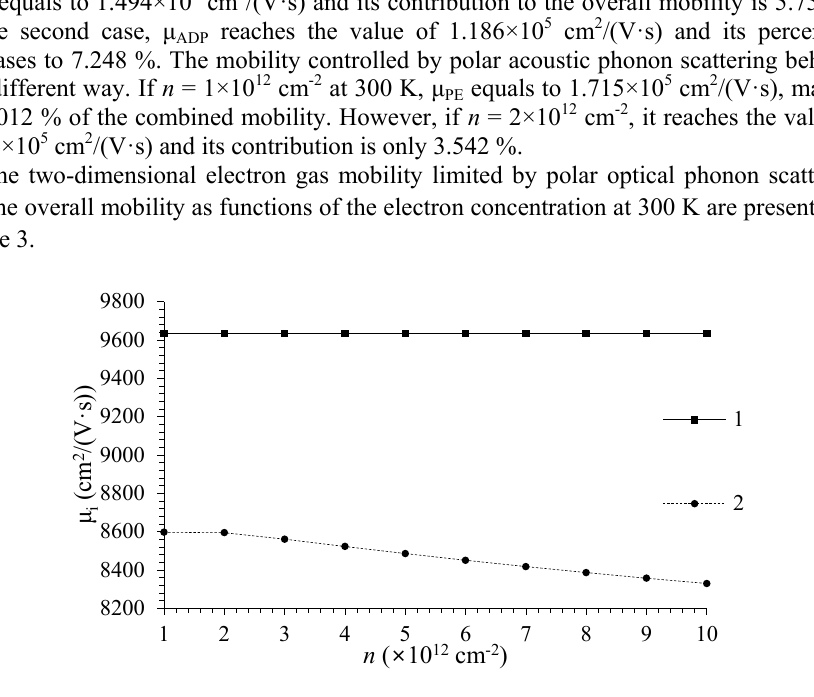
Fig. 3. Mobility of the two-dimensional electron gas as a function of its density at 300 K: 1 – polar optical phonon scattering, 2 – combined